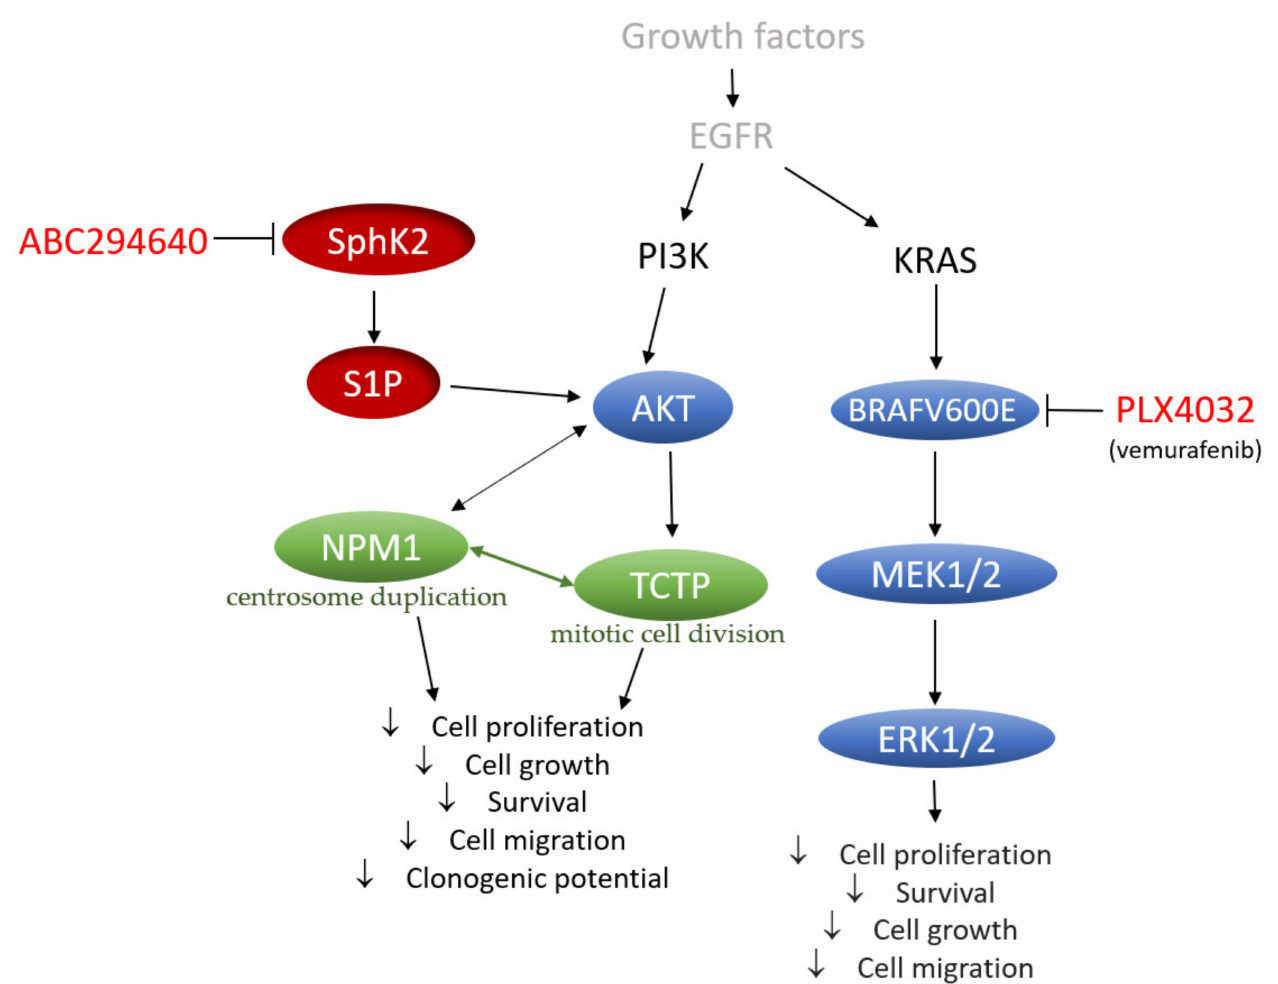
Figure 9. The proposed mechanisms underlying acquired resistance to vemurafenib in BRAFV600E mutant colon cancer cells including known (blue) and newly identified (red) features. Potential novel targets of combination treatment with ABC294640 and vemurafenib whose down-regulation concurs with chemosensibilization effect in vemurafenib-resistant RKO colon cancer cells are also shown (green). EGFR (epidermal growth factor receptor); SphK2 (sphingosine kinase 2); S1P (sphingosine-1-phosphate); NPM1 (nucleophosmin); TCTP (translationally-controlled tumour